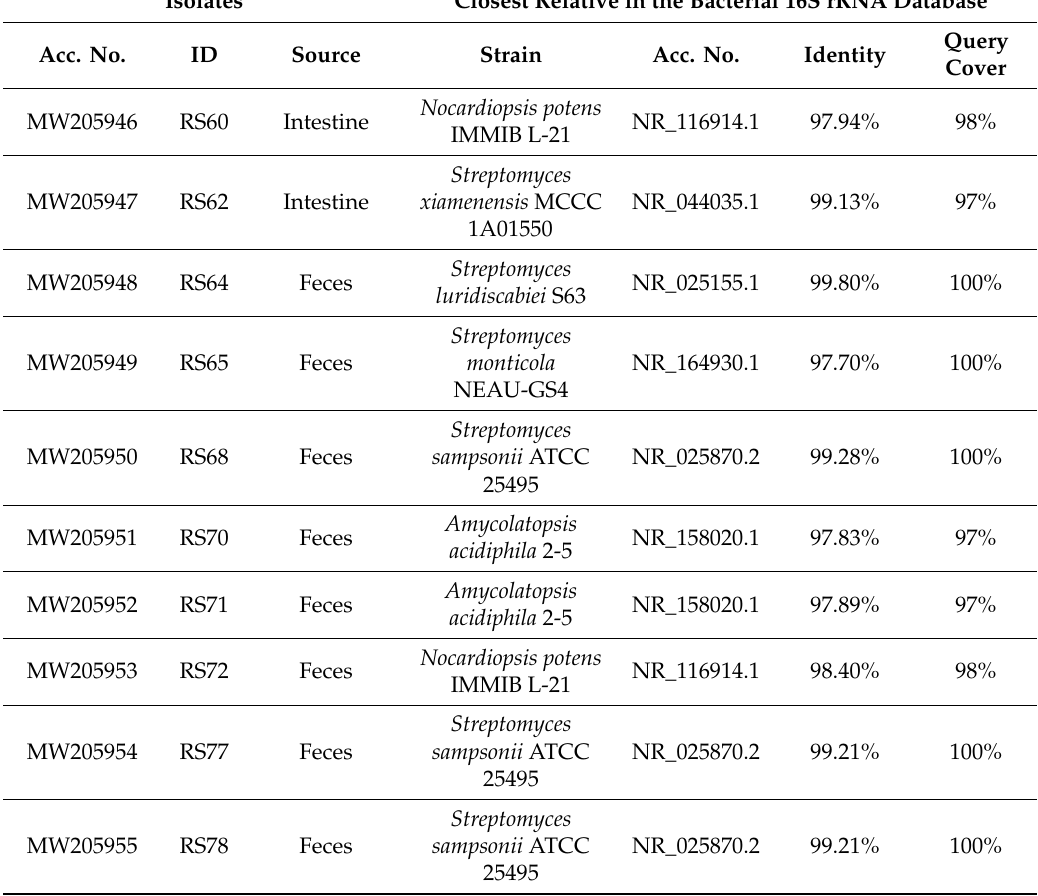
Table 3. Analysis of 16S rRNA sequences. Results from the comparison of the 16S rRNA sequences of the selected isolates to the Bacterial 16S Ribosomal RNA Database (NCBI). Only the closest relative obtained in each case is shown. Isolates Closest Relative in the Bacterial 16S rRNA Database Query Acc. No. ID Source Strain Acc. No. Identity Cover Nocardiopsis potens